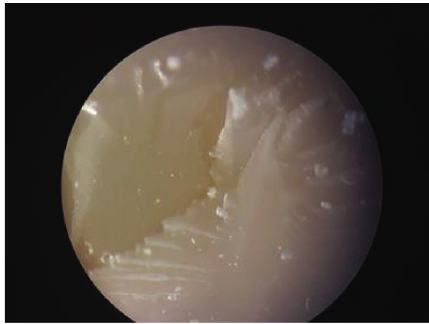
Figure 3: A specimen with mixed failure under stereomicroscope